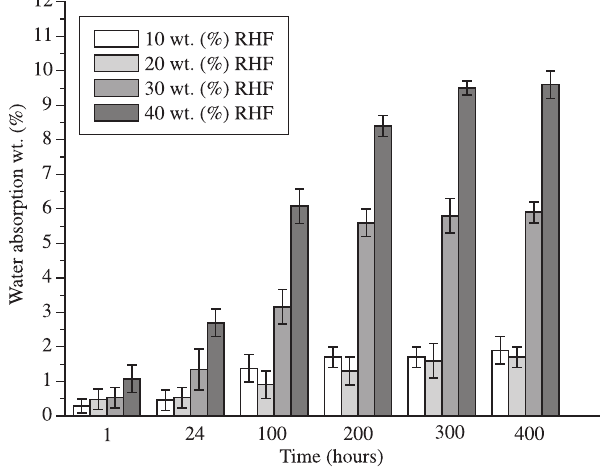
Figure 2. Effect of RHF and MAPP on Young’s modulus.